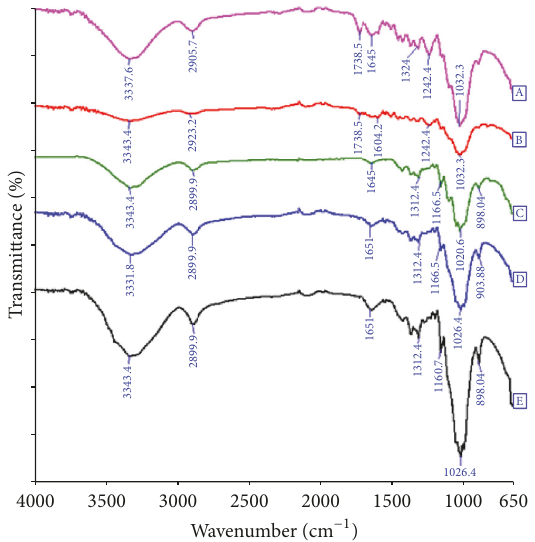
Figure 5: Wavelengths in FTIR of (A) jute fiber, (B) bamboo fiber, (C) commercial cellulose, (D) jute cellulose, and (E) bamboo